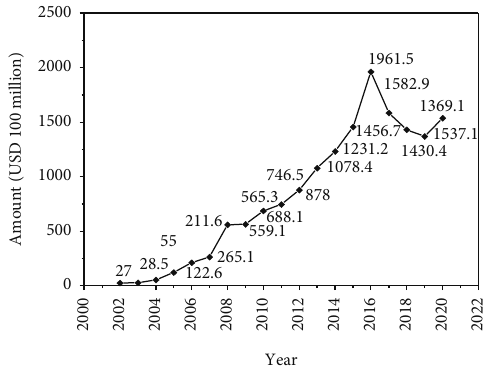
Figure 7: China ’ s outward direct investment fl ows from 2002